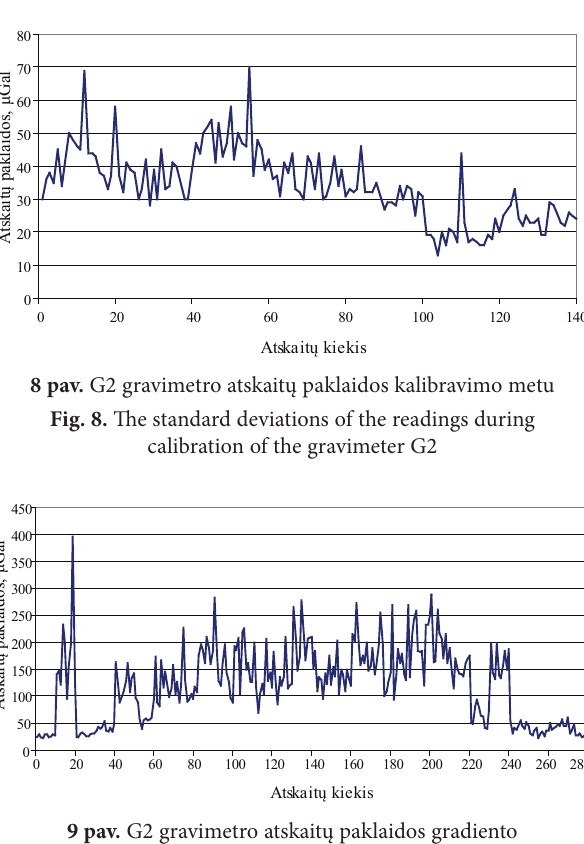
Fig. 9. The standard deviations of the readings during observations of vertical gradient of the gravimeter